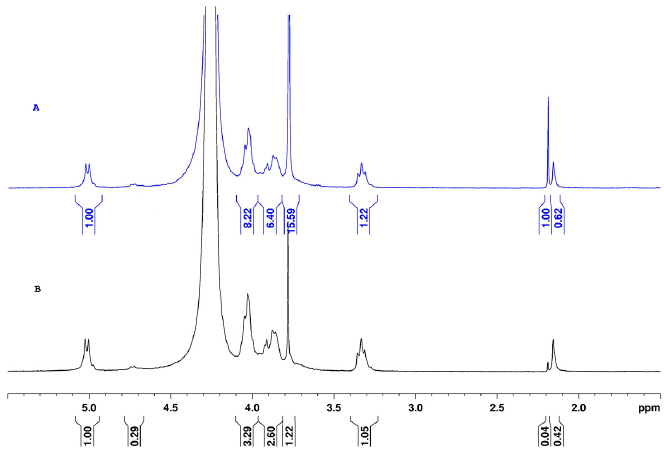
Figure 6. As spun fibers from the mixture CS/PEO (80/20) dissolved in acidic D 2 O ( A ); Stabilized and washed chitosan fibers from the mixture CS-102/PEO 80/20 dissolved in acidic D 2 O ( B ). From spectrum A, the amount of acetate groups was estimated and corresponded to a large part of the chitosan −NH (cid:2871)(cid:2878) counterions formed in presence of acetic acid. The proton of acetyl substituents also gave the DA, which was not modified in the electrospinning and washing processes. The PEO content in the material was clearly determined at 3.86 ppm but overestimated due to the overlap with one chitosan proton. After treatment with K 2 CO 3 and water, the NMR spectrum was simplified as shown in Figure 6B. The signal for the acetate –CH 3 groups was nearly suppressed: the ratio between the –CH 3 signals of acetate and acetyl equaled 1.60 in the initial fibers (A) and became lower than 0.1 (B). In addition, only a small amount of PEO remained: the ratio of proton integral of –CH 2 – from PEO and that of chitosan H-2 equaled 1.22/1.05 which is negligible in comparison of the same ratio in Figure 6A giving 15.59/1.22.